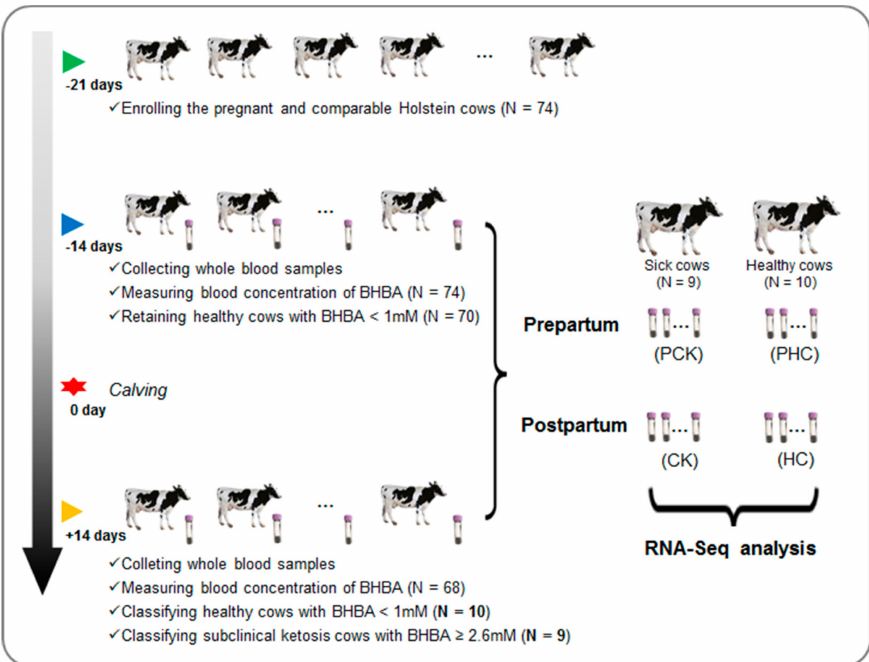
Figure 1. An overview of the experiment design and sample